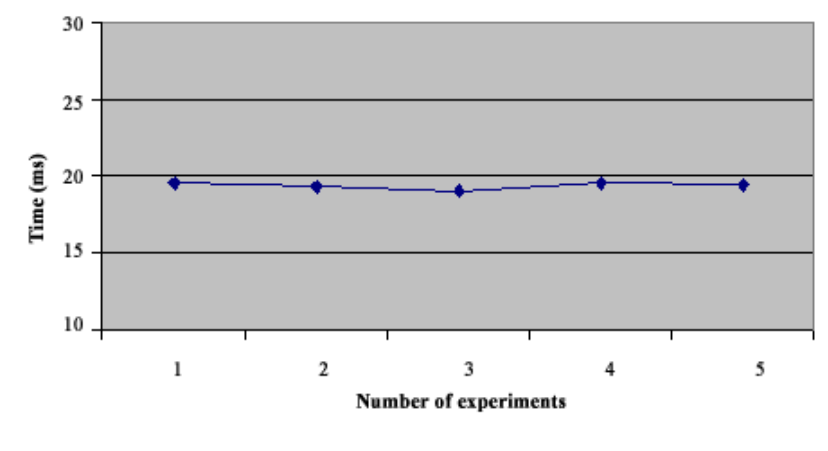
Figure 9. Convergence Time of Topology 1.